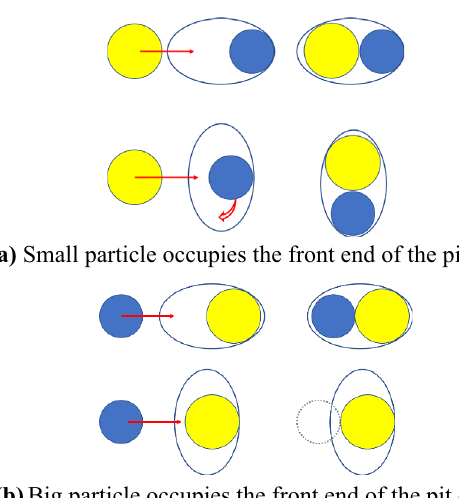
Figure 10 Comparison of particle collection ability between Ellipse-1 and Ellipse-2